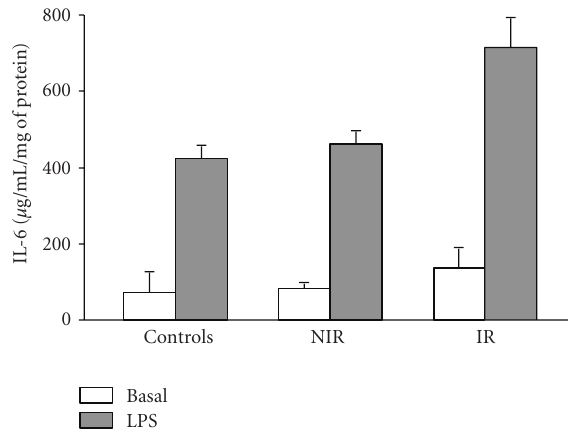
Figure 3: Il-6 secretion in LPS activated monocytes from PCOS and control girls. Each value represents mean ± SEM of 8 separated experiments. ∗ LPS-activated monocytes from PCOS versus LPS- activated monocytes fromcontrols, P < .05, by Student’s t